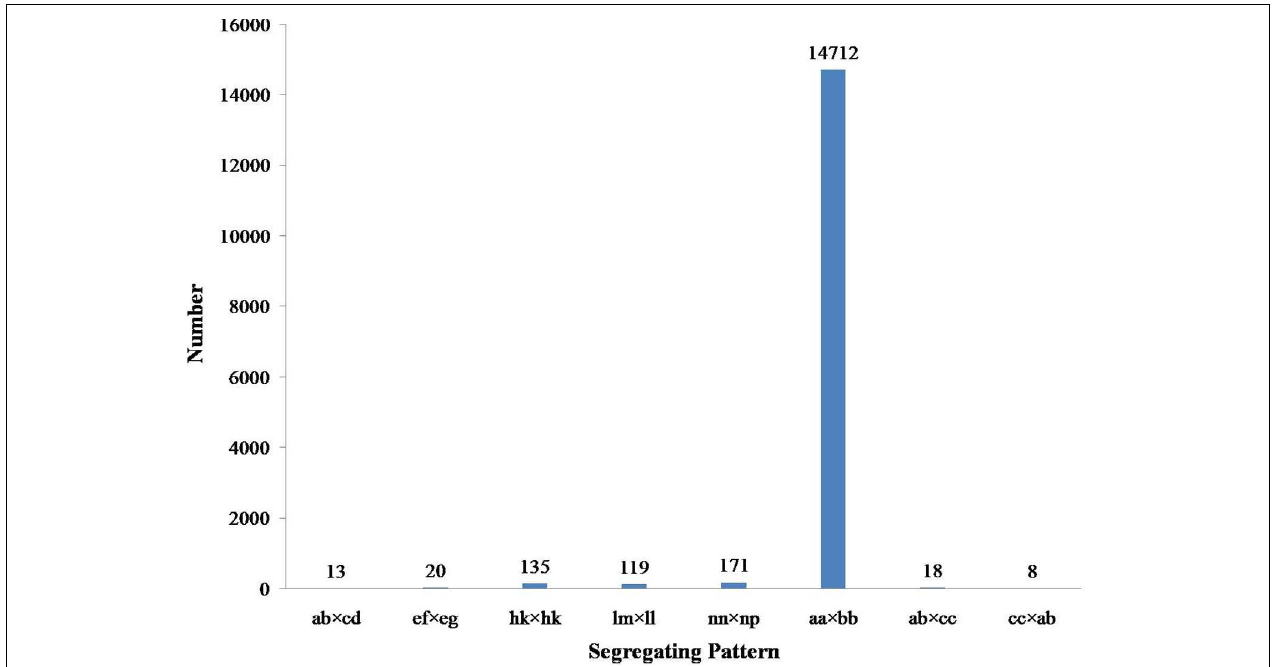
FIGURE 2 | Gnotype distribution of SLAF markers. The Y axis is the number of SLAFs, the X axis is the type of SLAFs.